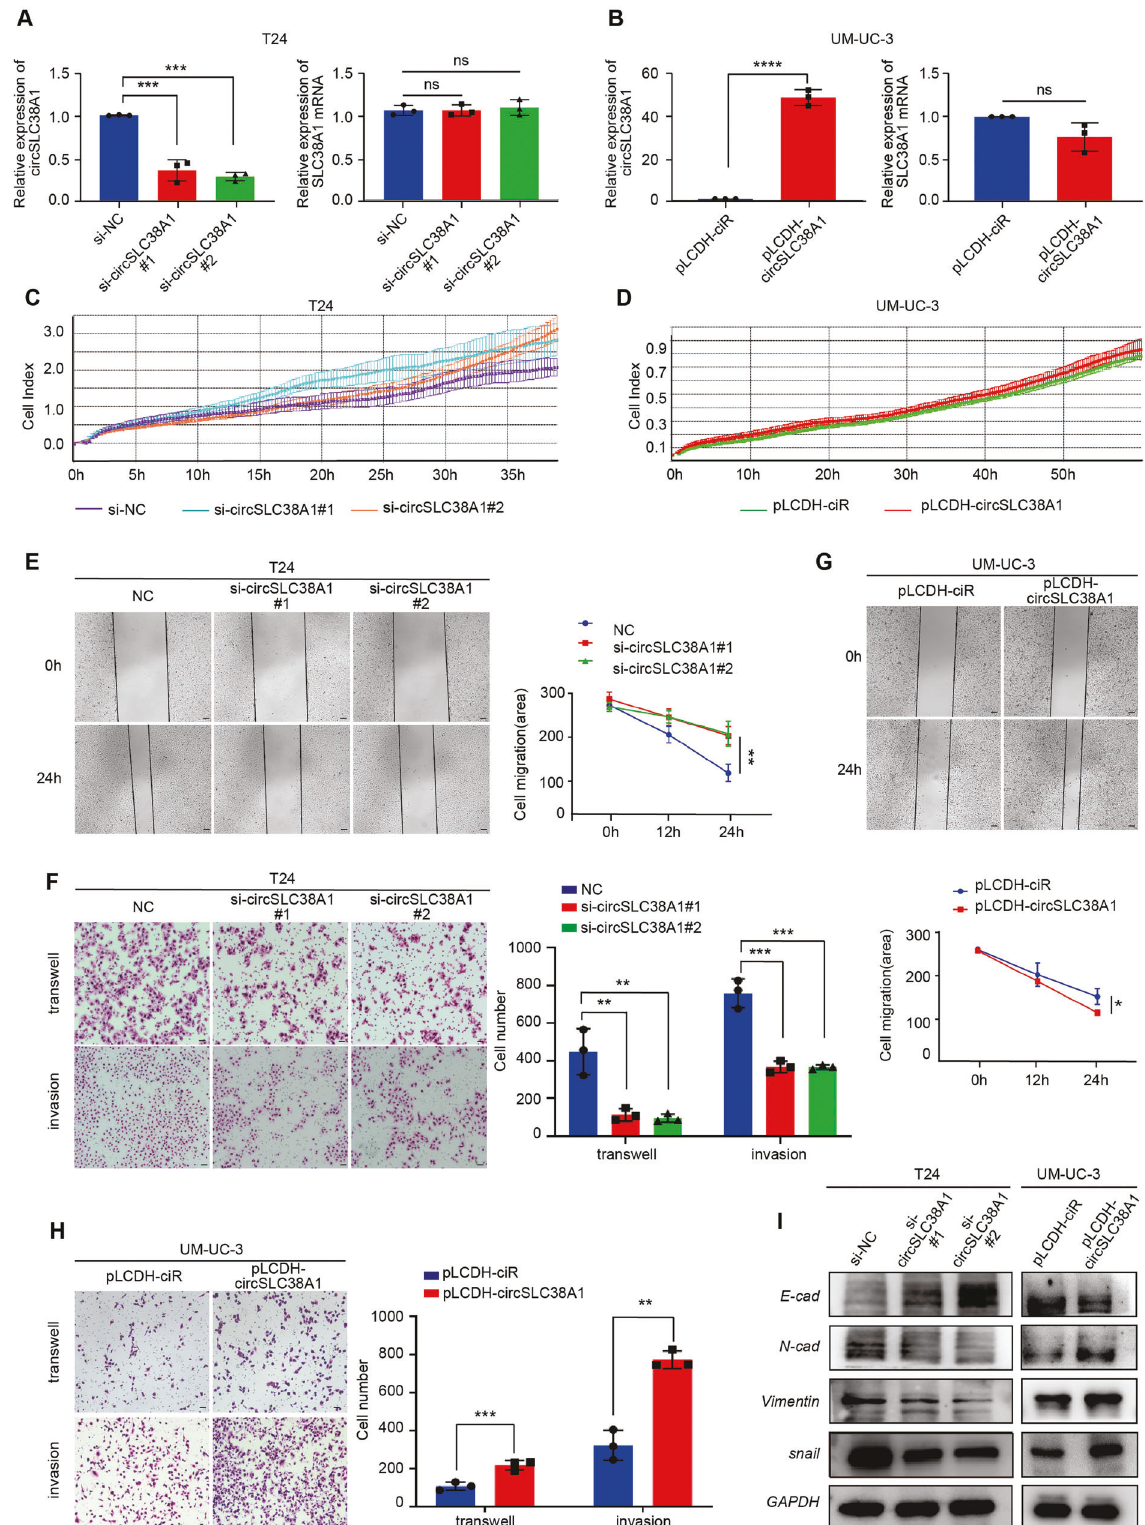
the protein extracted from cells was incubated with anti-Flag M2 Magnetic Beads (Lot#SLCF4223) (Sigma) at 4 °C. After incubation overnight, the magnetic beads were collected and washed 5 times in PBST for 5